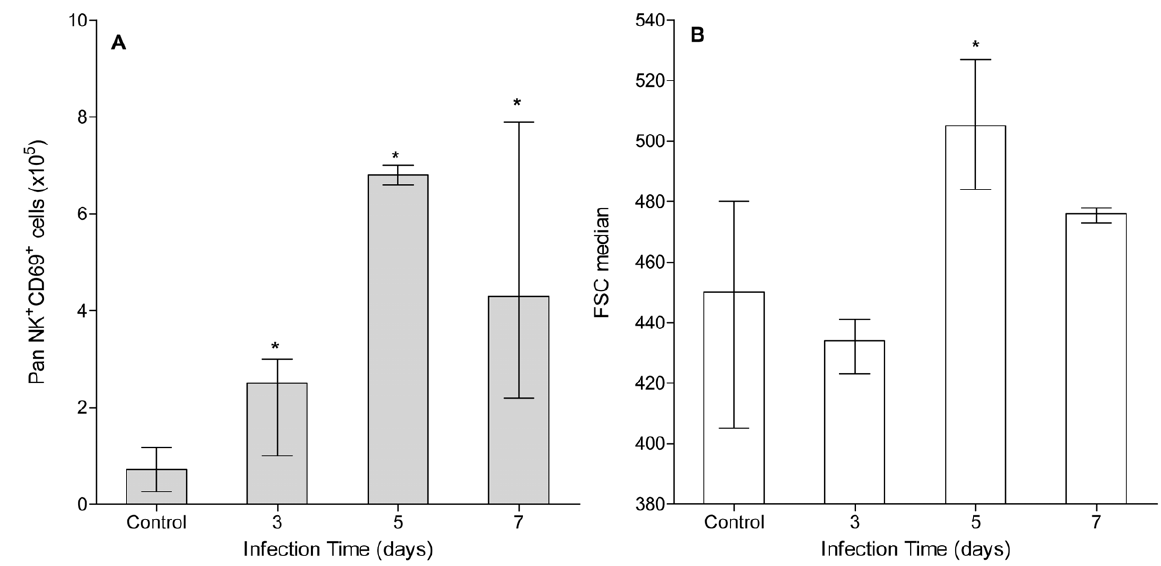
Figure 3. Peritoneal NK cells show a significant rise with a proportion of activated cells. A group of mice (n=9) was inoculated ip with 2000 protoscoleces and another group (n=6) was inoculated with equal volume of sterile PBS (control group). Three infected and 2 control animals were sacrificed at days 3, 5 and 7 pi and their peritoneal activated NK cells (A) as well as median cellular size (B) were determined. Results are shown as group median and data range. (*) Statistical significance (p , 0.05) compared to control group. Results are representative of two independent experiments.